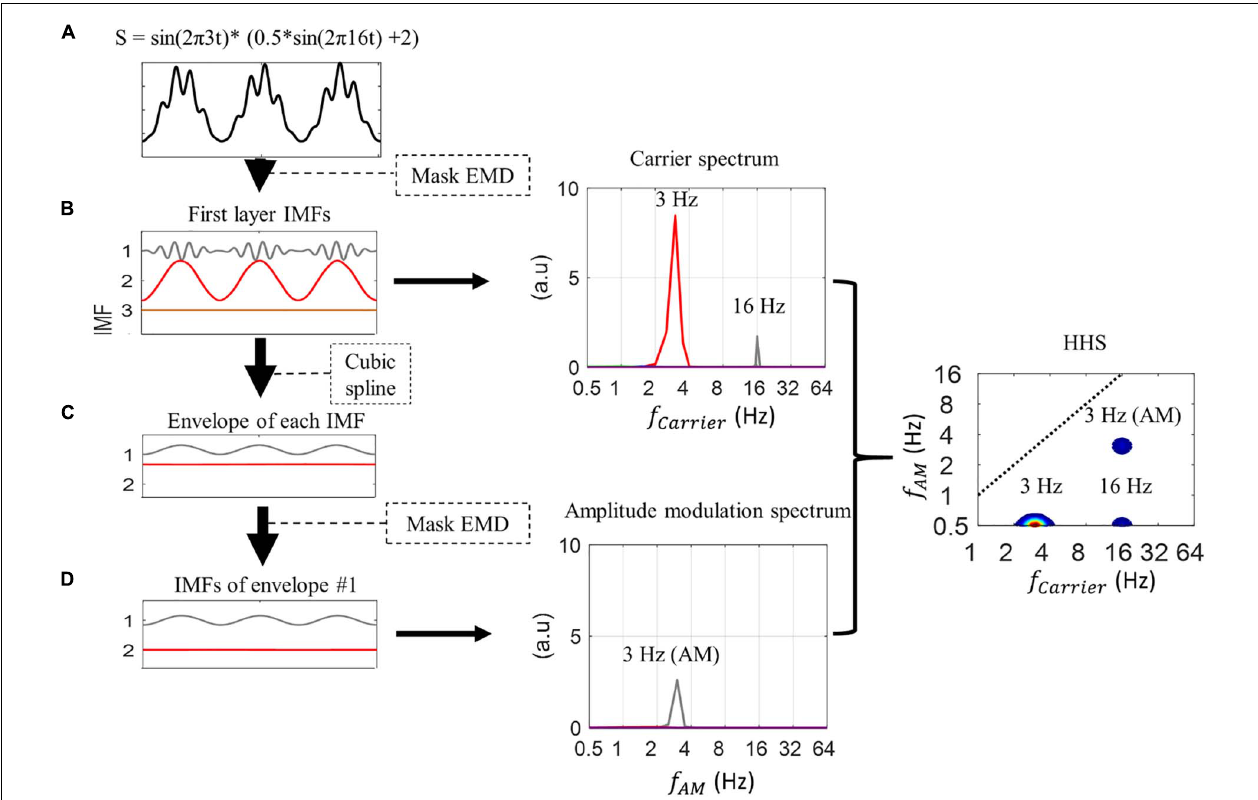
FIGURE 1 | Illustration of the process of Holo-Hilbert spectrum analysis. (A) The PAC simulated signal is decomposed into three intrinsic mode functions (IMFs) by Mask EMD to produce the first layer IMFs. (B) In this layer, IMF1 corresponds to the high-frequency signal (i.e., amplitude-modulated signal with 16 Hz signal modulated by 3 Hz, see section “Experimental Data”), while IMF2 corresponds to the low-frequency signal (3 Hz). The marginal amplitude spectrum of the first layer IMF shows amplitude peaks at 3 and 16 Hz, respectively. (C) The envelope of each IMF is extracted using cubic spline interpolation. The Mask EMD is then applied to each envelope again to acquire second layer IMFs. (D) In this case, we only illustrate the second layer IMFs of the first envelope. The amplitude modulation spectrum shows the peak amplitude of IMF1 at 3 Hz, which correspond to the 3 Hz amplitude modulation of the amplitude-modulated input signal. The carrier spectrum and amplitude modulation spectrum are combined to build the two-dimensional frequency spectrum, as known as HHS, in which the x -axis represents the carrier frequency (fc), and the y -axis represents the amplitude modulation frequency (fam). The HHS shows separate peak amplitudes at 3 Hz (at 0.5 Hz y -axis) of the sinusoidal signal, and 16 Hz (at 0.5 Hz y -axis) and 3 Hz AM of the amplitude-modulated signal. In the current study, all AM power below 0.5 Hz has been collapsed to the 0.5 Hz AM frequency bin in the HHS. The display of carrier frequencies at 0.5 Hz on the y -axis (AM frequency) might not affect the observations of higher AM frequency in the signal. The frequency axes are in dyadic